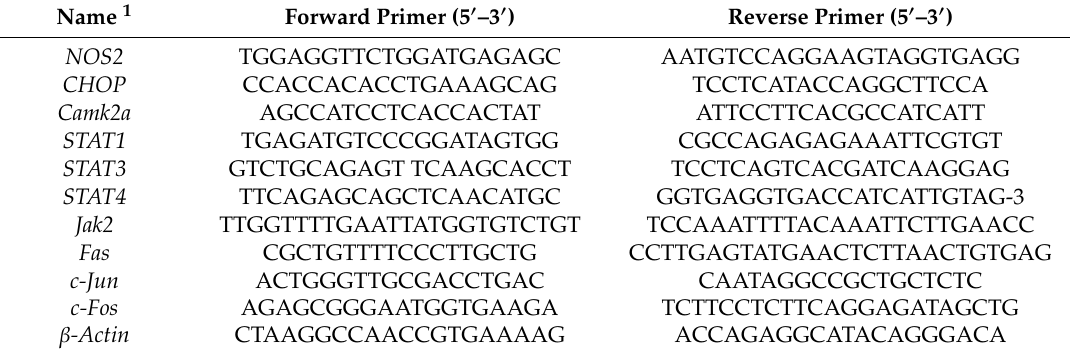
Table 1. Primers used for quantitative